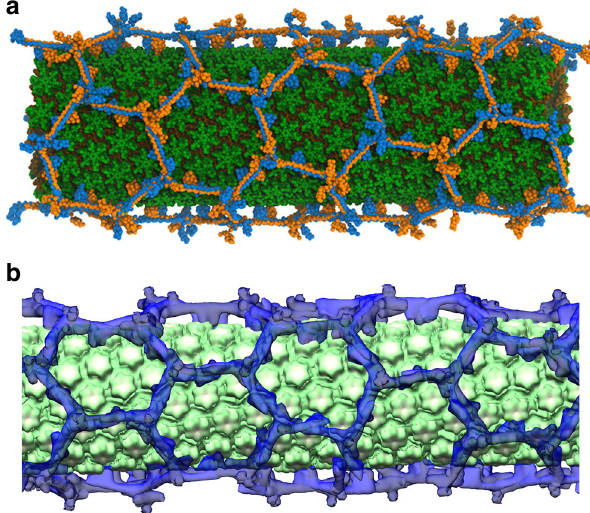
Fig. 4 TRIM5 α assembles into hexagonal lattices on capsid tubes. a Simulation endpoint for the TRIM5 α assembly process on a cylindrical surface. b Electron cryotomography (cryo-ET) reveals that TRIM5 α forms hexagonal lattices on the surface of CA